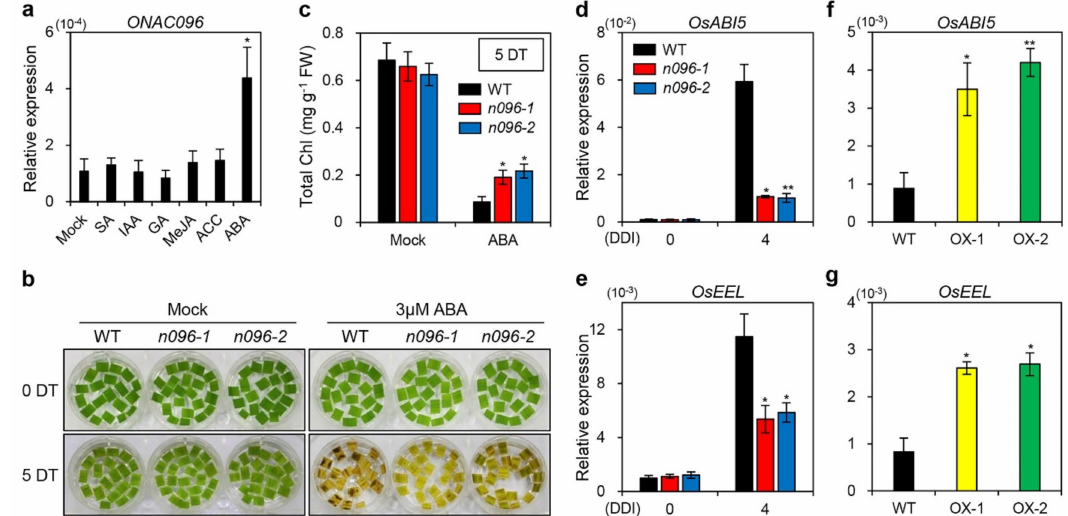
Figure 7. Abscisic acid (ABA) hyposensitivity of onac096 mutants. ( a ) WT seedlings were grown in MS Phytoagar medium for 10 d under continuous light conditions at 28 ◦ C, followed by incubation in